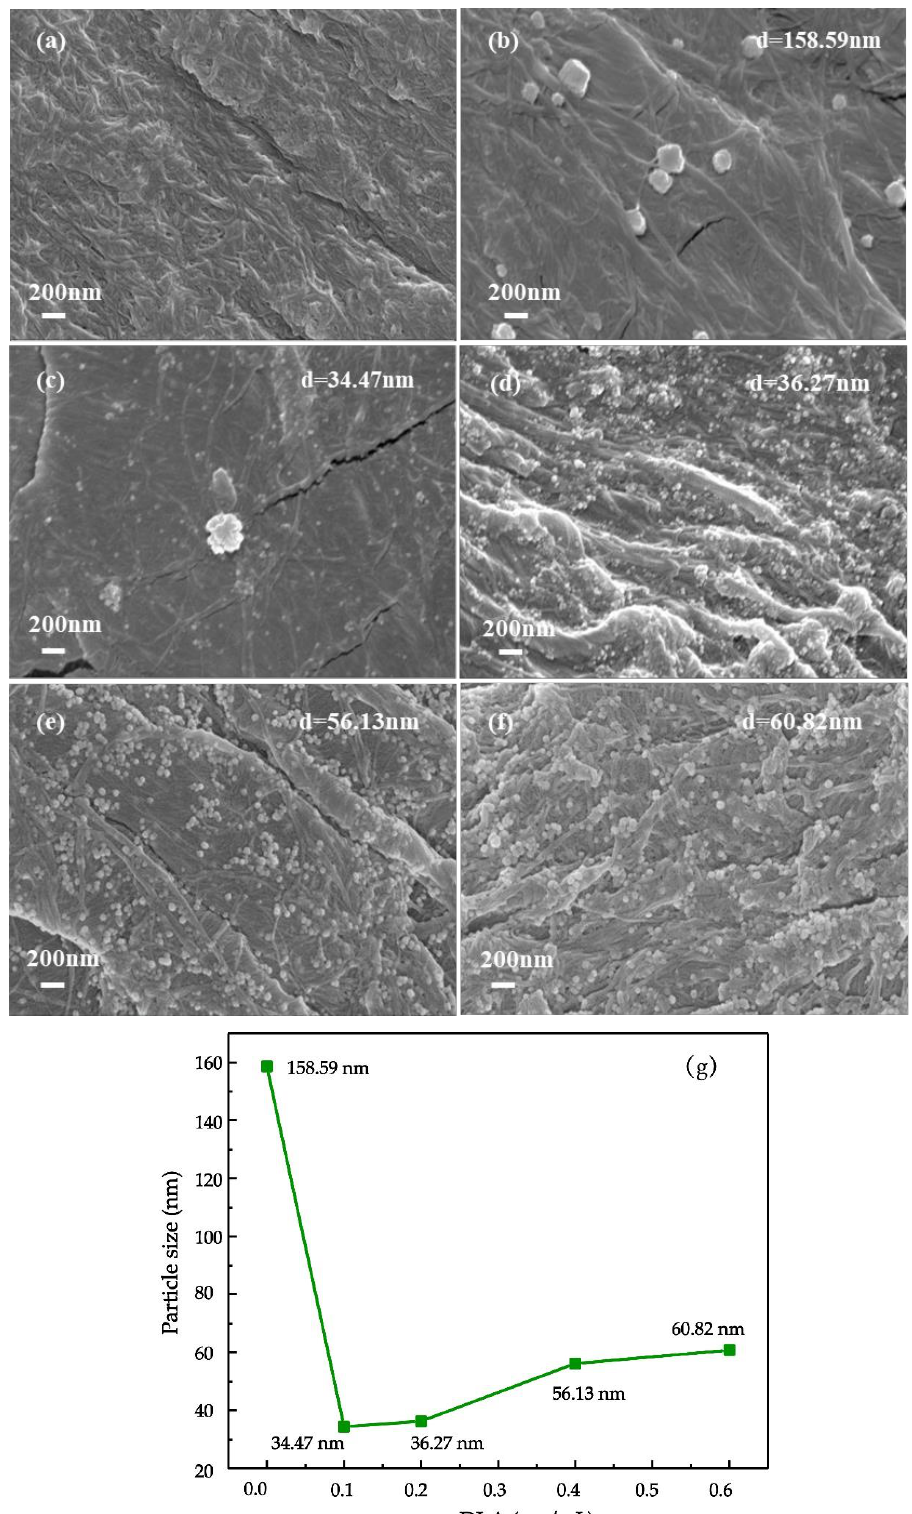
Figure 1. The SEM images of ( a ) bhpFibers and bhpFibers@AgNP-based paper prepared by 20 mM AgNO 3 and di ff erent concentrations of DLA: ( b ) 0 mg / mL, ( c ) 0.1 mg / mL, ( d ) 0.2 mg / mL, ( e ) 0.4 mg / mL and ( f ) 0.6 mg / mL; ( g ) silver particle sizes at di ff erent concentrations of